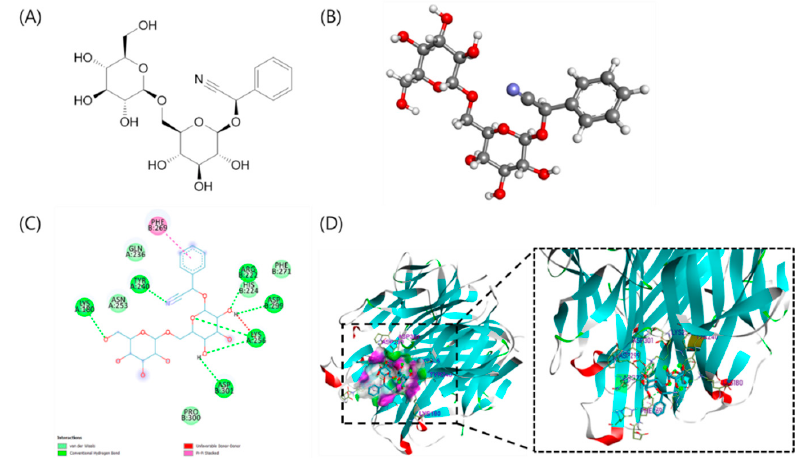
Figure 1. Molecular docking simulation of the interaction between AD and the 1IQA protein of RANKL expression. Structure of amygdalin (AD) ( A ) in 2D and ( B ) 3D. Interactions between AD and associated residues in the interface of the homology model for RANKL proteins in ( C ) 2D and ( D ) 3D were generated using the Discovery Studio.